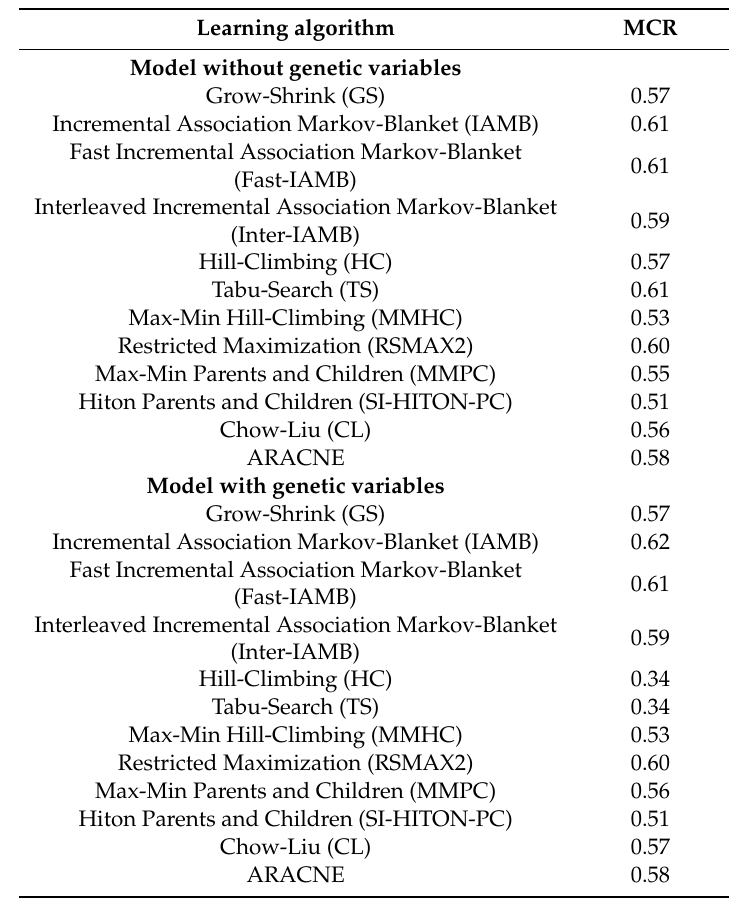
Table 2. MCR of the networks learned with di ff erent algorithms. The selected algorithms were the ones implemented in the “bnlearn” R package. Performances for networks with and without genetic variables are